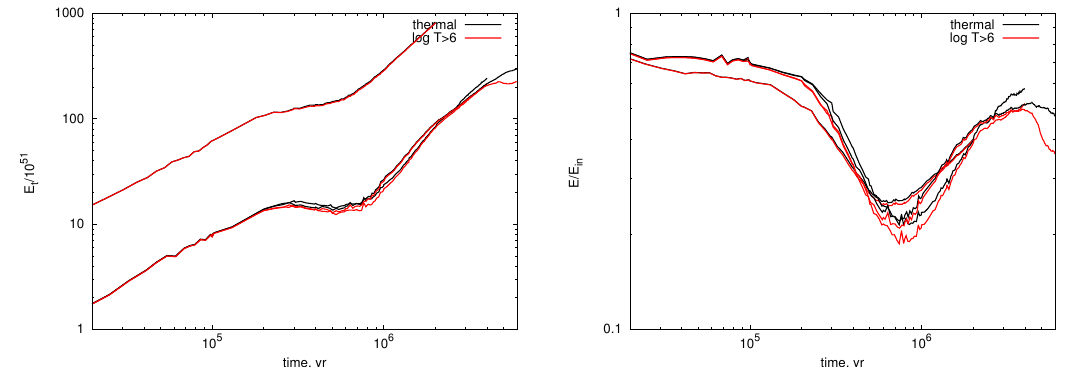
Figure 3. ( Left ) Thermal energy in a superbubble from sequential SNe explosions in a stratified ISM in the Galactic center; black lines depict the total thermal energy, red lines—thermal energy of gas with T > 10 6 K, upper curves are for the SN rate 10 − 3 yr − 1 , lower are for 10 − 4 yr − 1 , SNe explode in a cluster of radius r c = 30 pc, gas scale height is 100 pc, the halo gas component has constant density n h = 10 − 4 cm − 3 . ( Right ) The ratio of thermal to total injected energy for all three model in the ( Left ) panel. The flattening of the energy growth is clearly seen in the ( Left ) panel between 0.3 and 0.8 Myr for lower SN rate, and between 0.2 and 0.6 Myr for higher SN rate. After the flattening radiative losses in the disk become inefficient compared to continuously injected energy, and thermal energy grows almost linearly. Later on, at around 1 to 4 Myr radiation increases in the shell when the downward parts of the shock wave cover a considerable fraction of the ISM disk. From